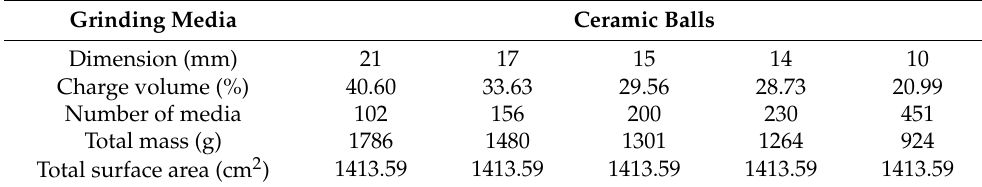
Table 7. Ceramic balls with the same total surface area as cylpebs (12 × 12 mm).